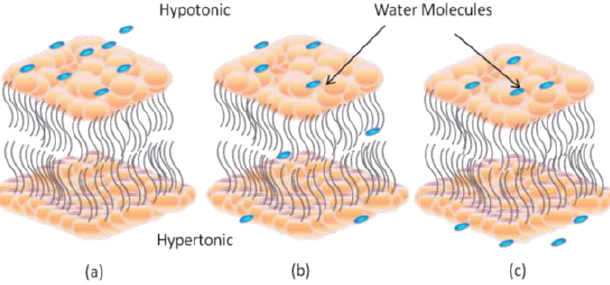
Figure 2. Bilayer lipid membrane osmosis process. ( a ) Water molecules flow at higher concentration (hypotonic); ( b ) Water molecules move from hypotonic region (high extracellular concentration) to hypertonic region (low extracellular concentration) across the LBM; ( c ) Water molecules are at equilibrium